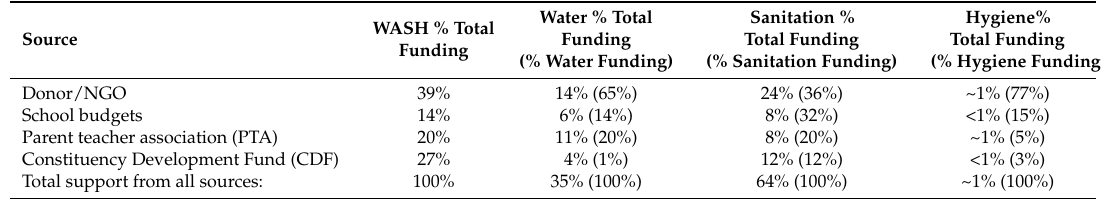
Table 2. Breakdown of reported source of funding for each WASH component and expenditure of water, sanitation and hygiene by that source—data from 89 schools across three counties in Kenya, 2014. Water % Total WASH % Total Source Funding